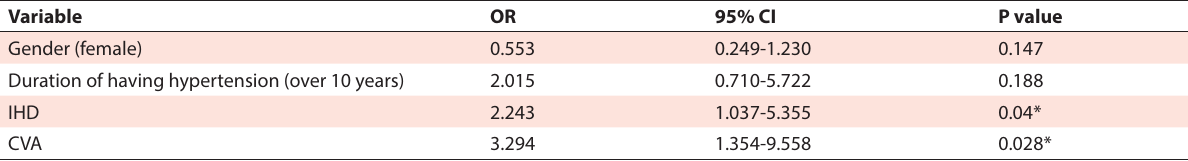
Table 4. Multivariate logistic regression between ICH volume and the studied